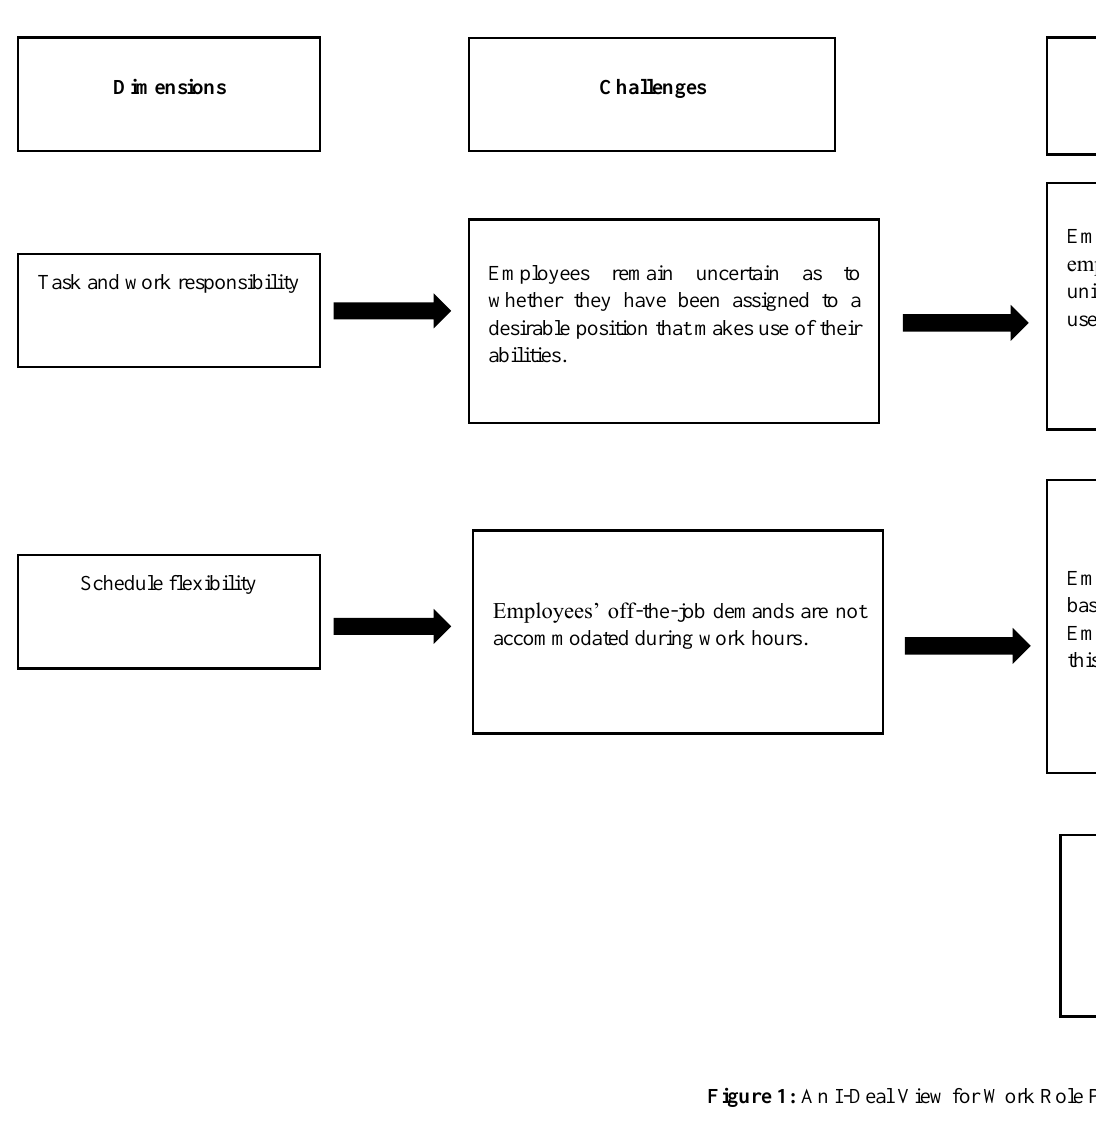
Figure 1: An I-Deal View for Work Role